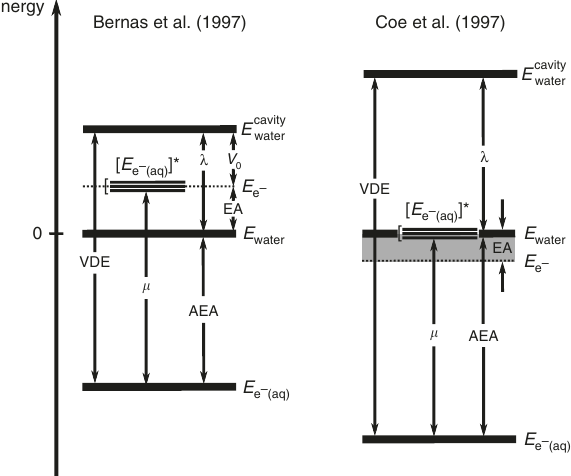
Fig. 3 Energy diagrams of solvated electron inferred from past work. The diagrams are derived from the work of Bernas et al. 15 (left) and Coe et al. 16 (right). The notation is the same as in Fig. 2. The zero of both diagrams corresponds to the energy of pristine, neutral water, E water . Bernas et al. used AEA = 1.47 eV 70 , while Coe et al. adopted AEA = 1.72 eV. On the left, λ = 1 eV 49, 50 was taken from a theoretical study and μ = 1.73 eV from optical absorption experiments 48 . On the right, VDE = 3.32 eV 55 was extrapolated from cluster data. Ref. 15 (left) assumed that the energy of pristine water with an added electron (prior to ionic relaxation) coincides (cid:1) (cid:3) with the fi rst excited state of the solvated electron E e (cid:2) aq ð Þ